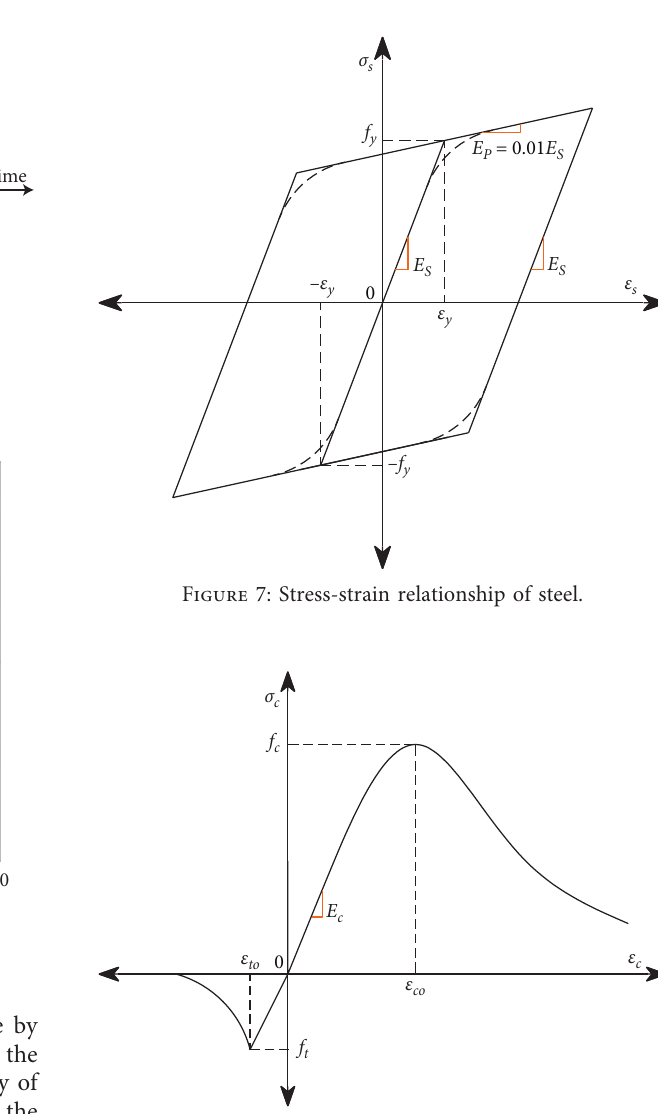
Figure 8: Stress-strain relationship of concrete.